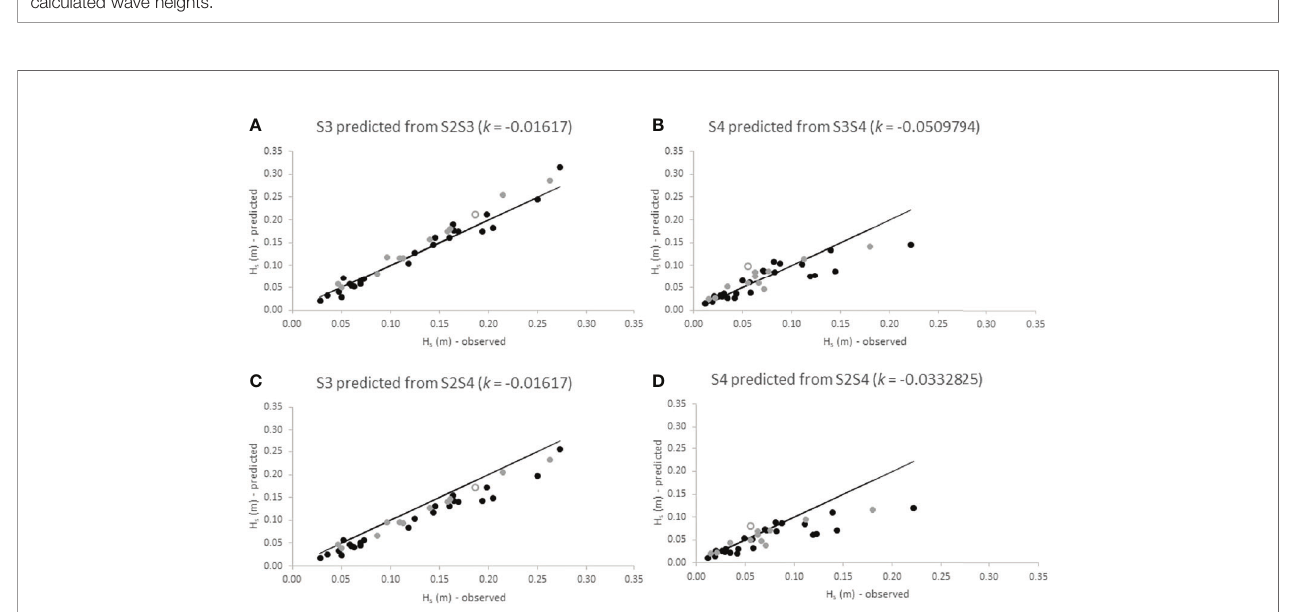
FIGURE 8 | Observed signi fi cant wave heights at the landward location of transect sections S2S3 (A) , S3S4 (B) and S2S4 (D) at Cape Dolosman compared to wave heights calculated at those locations using the best- fi t dissipation coef fi cient ( k ) as derived from observed wave height dissipation over all seasons for those respective transect sections. Panel (C) shows wave heights predicted for the middle location (S3) on the basis of k derived from observed dissipation between S2 and S4. Data is shown per season (open circles = summer; black dots = winter; grey dots = spring). Black lines indicate lines of direct correspondence between observed and calculated wave